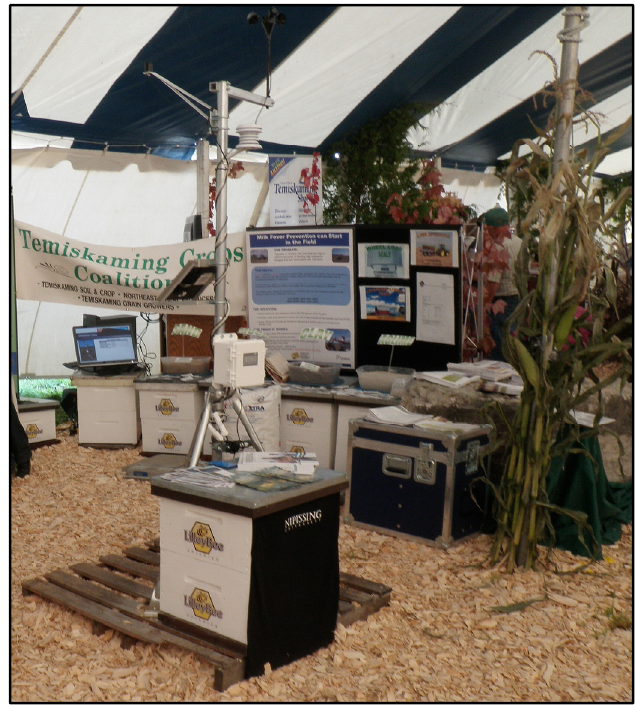
Figure 9. Nipissing weather station as part of the Ontario Soil and Crop Improvement Association/Temiskaming Crops Coalition booth at the 2009 International Plowing Match. The event was held for the first time in Earlton with an estimated 75,000 visitors over 5 days.